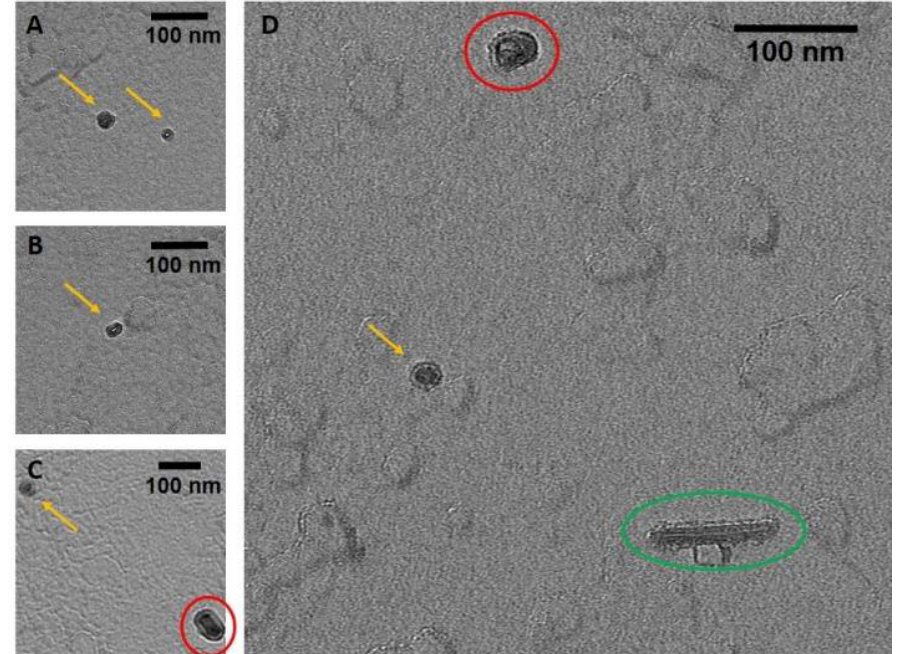
Figure 1. TEM images of the stab-1 HCC oligomers. Selected TEM images of the stab-1 HCC doughnut-like oligomers stained with uranyl acetate (yellow arrows, panels A – D ) showing representative species present in the samples. Small numbers of short fibrils (green oval, panel D ) and higher molecular weight oligomers (red circles, panels C , D ) are also evident. Scale bars are 100 nm in each case.